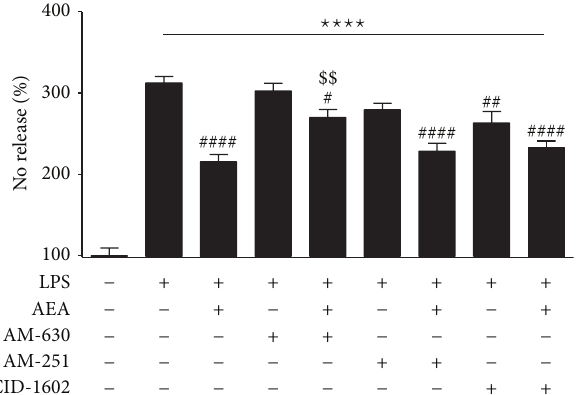
Figure 2: Release of nitric oxide in cultured rat primary microglia after LPS stimulation and pretreatment with AEA and AM-630, AM-251, or CID-16020046. The results are expressed as the per- centage of NO release relative to the nonstimulated control (100%), 24 hours after LPS stimulation. Data are presented as the mean ± SEM and represent the normalized averages derived from 10 to 15 samples per group. Statistical analysis was performed using one- way ANOVA followed by Bonferroni post hoc tests. Statistical 𝑃 values < 0.05 were considered significant. * It denotes a significant difference versus the nonstimulated control; #, versus the LPS- stimulated control; $, versus the LPS-stimulated cells treated with